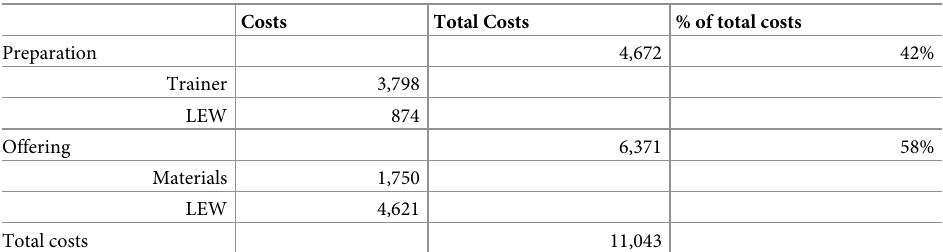
Table 3. Overview of costs in